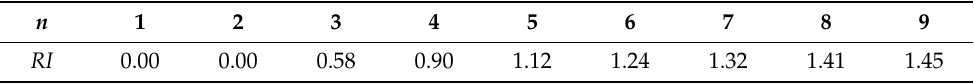
Table 6. The relationship between the consistency index ( RI ) and n